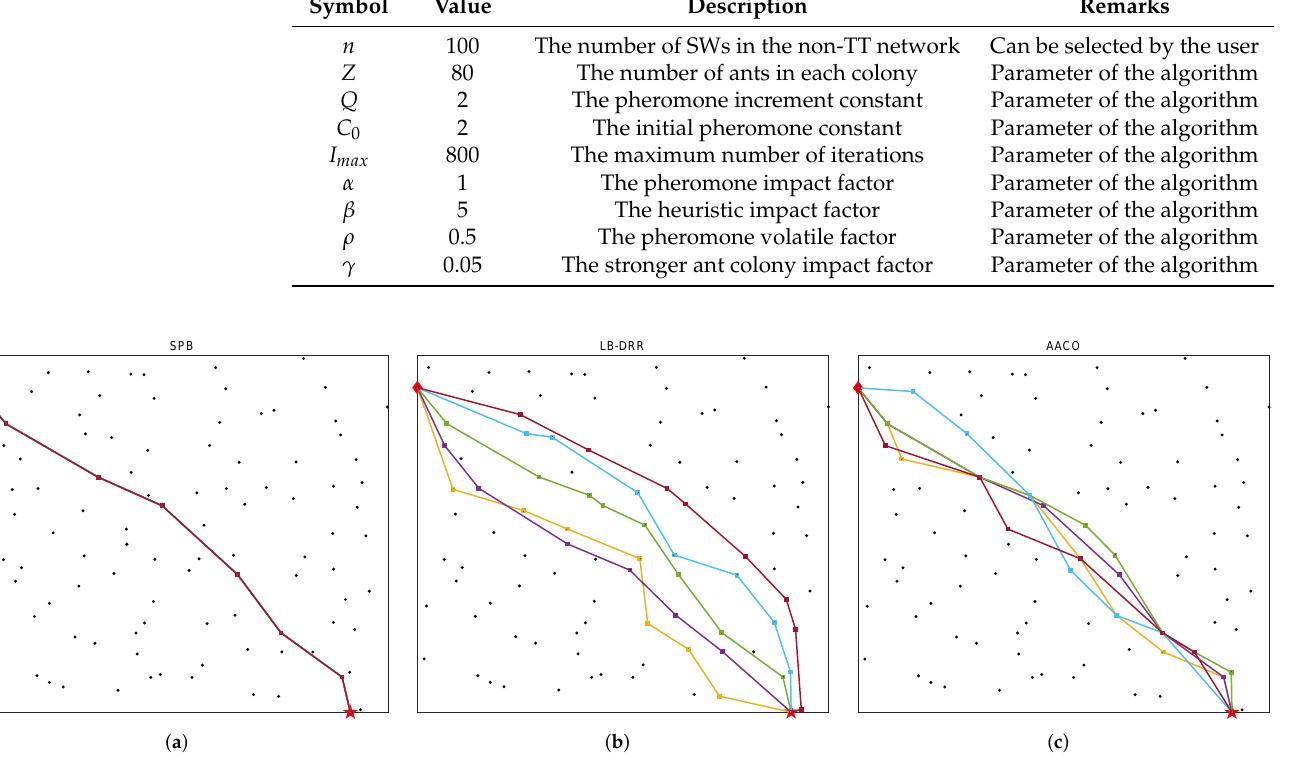
Figure 15. Comparison of the three algorithms for non-TT routing: ( a ) routes assigned by the SPB; ( b ) routes assigned by the LB-DRR; ( c ) routes assigned by the